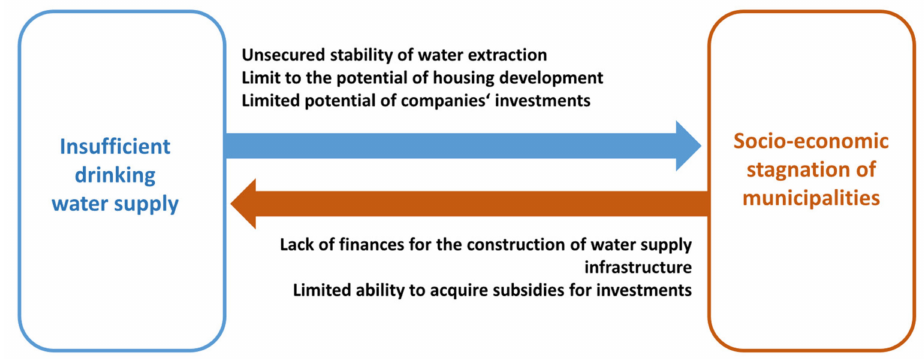
Figure 9. Circular causality scheme of the development deprivation of municipalities with problem- atic drinking water